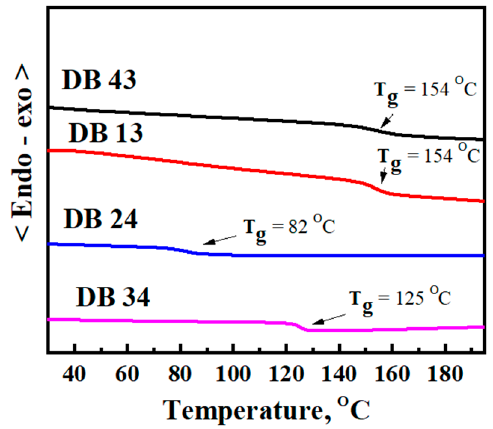
Figure 10. DSC curves of second heating for estimating glass transition temperatures ( T g ) of the compounds DB13, DB24, DB34, and